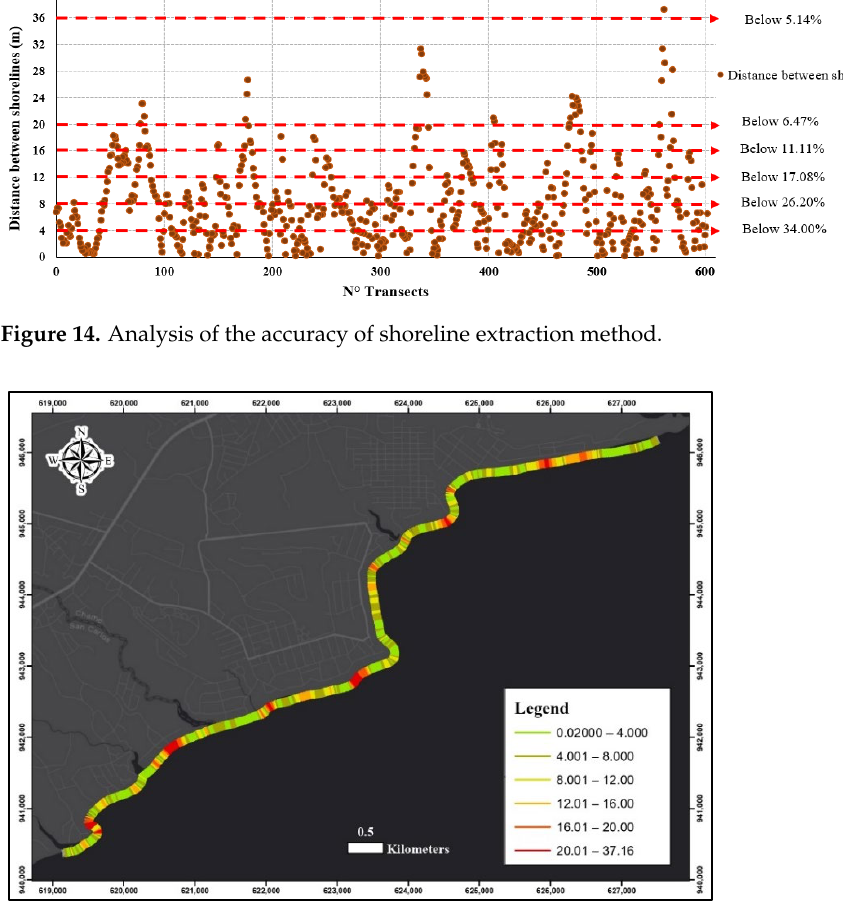
Figure 15. Distance between shoreline of the High-Resolution image vs. shoreline of Medium Resolution image.